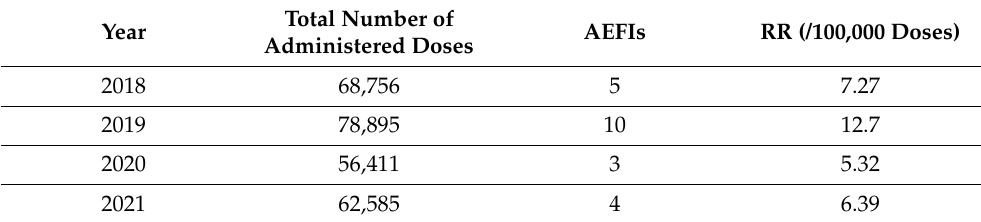
Table 1. AEFIs reporting rates during 2018–2021.